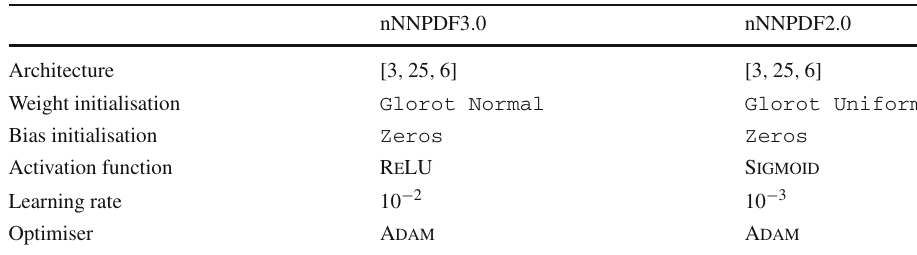
Table 2 The neural-network hyperparameters used in nNNPDF3.0, determined by means of the automated hyperoptimisation algorithm, compared with its counterparts determined from trial and error selection in